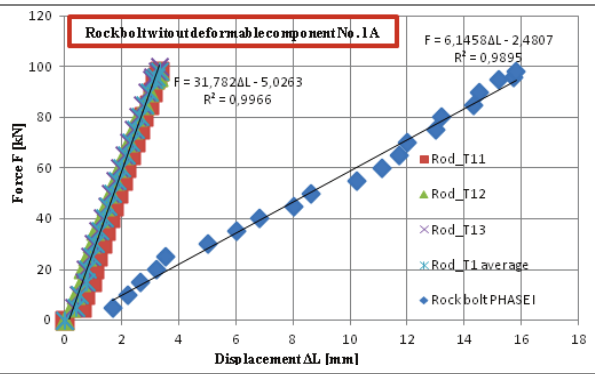
Fig. 27. Detailed loading characteristics for the components of the rock bolt support No.